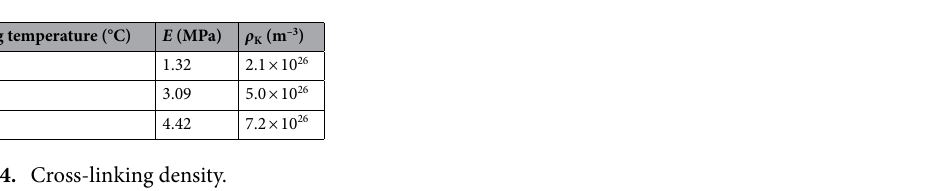
Table 4. Cross-linking